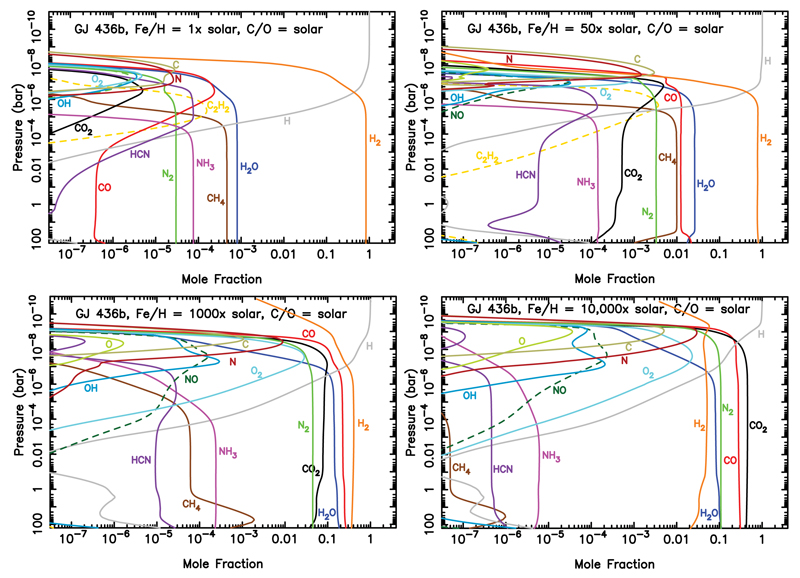
Vertical mixing-ratio profiles for several major atmospheric constituents in disequilibrium thermo/photochemical models of GJ 436b, for assumed metallicities of 1× solar (top left), 50× solar (top right), 1000× solar (bottom left), and 10000× solar (bottom right). Note the major change in the abundance of CO2, CO, and CH4 with the increase in metallicity (figure from Moses et al. 2013a)